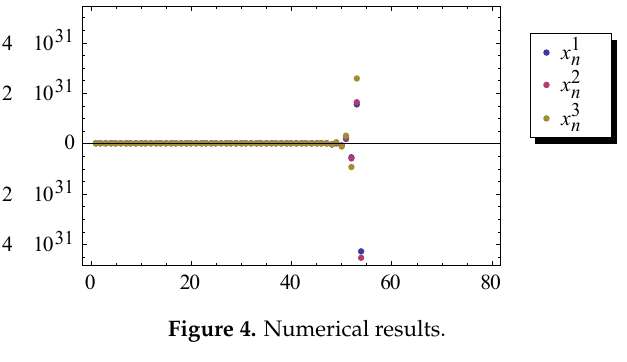
Figure 4. Numerical results.